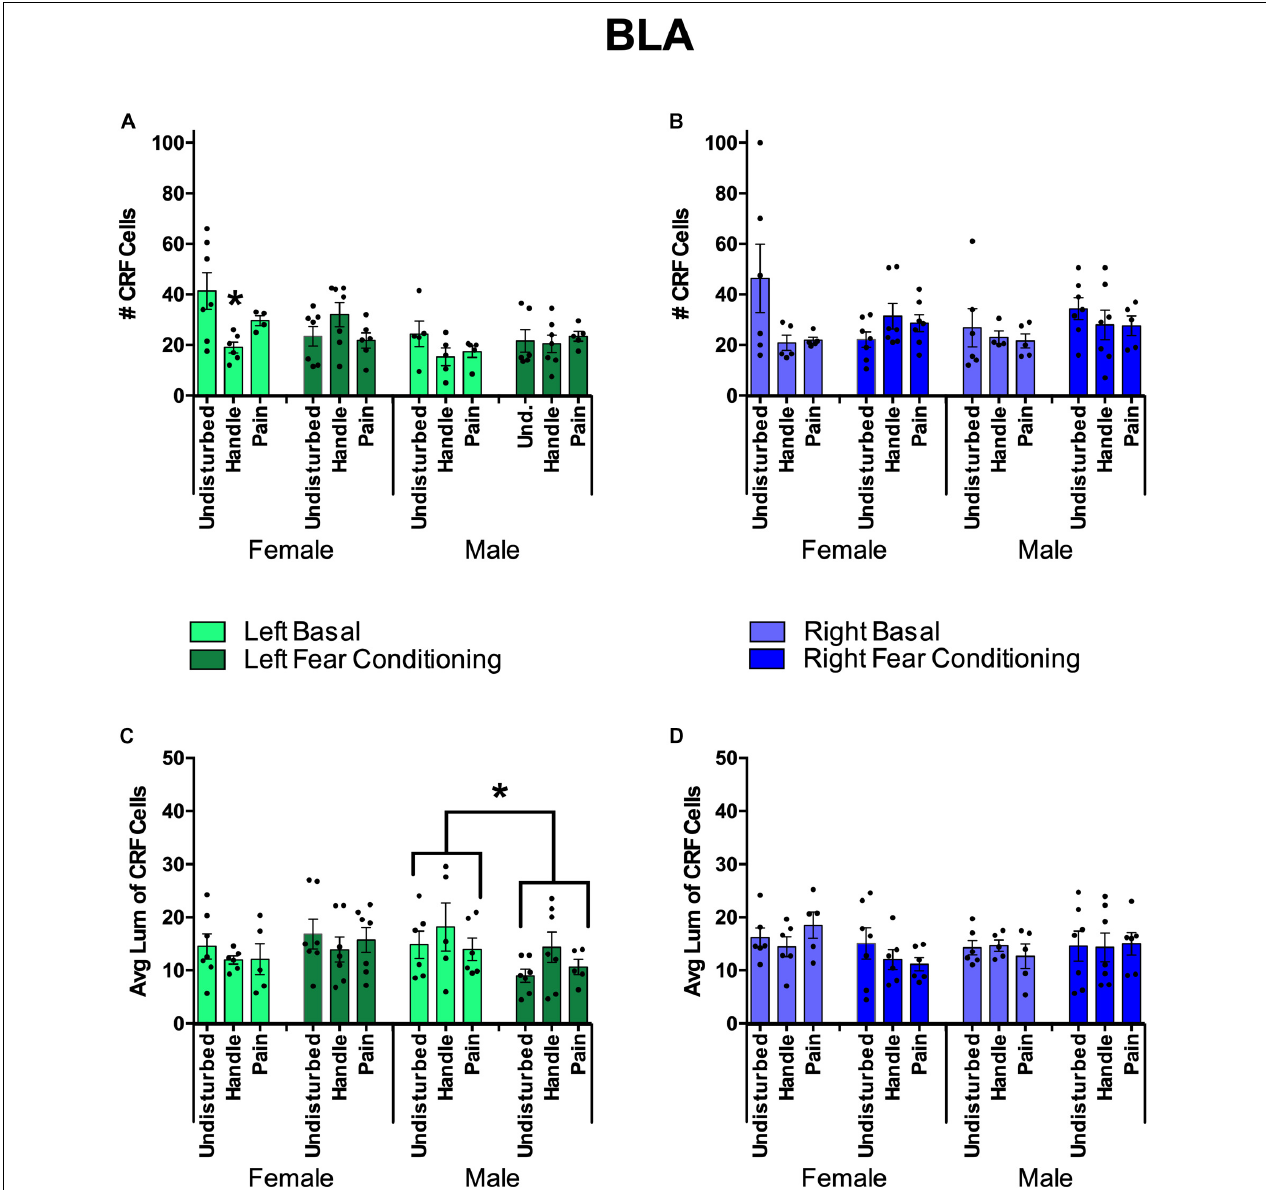
FIGURE 10 | Basolateral Amygdala (BLA) Quantification of FISH Product Corticotropin Releasing Factor (CRF) under neonatal conditions (Pain, Handled, and Undisturbed) and juvenile conditions (basal and fear conditioned) in PND 24 rats. (A) Number of CRF+ cells within the left BLA. (B) Number of CRF+ cells within the right BLA. (C) Average luminance of CRF+ cells within the left BLA. (D) Average luminance of CRF + cells within the right BLA. N’s ranged four to seven subjects per group. Data are presented as means with error bars as ± SEM; *denotes significant ( p < 0.05) difference between indicated